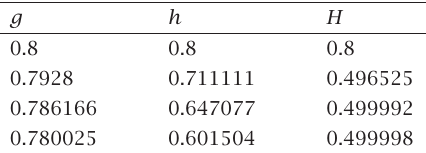
Table 4.2 . h = C(x,g) , H = C(g,h)